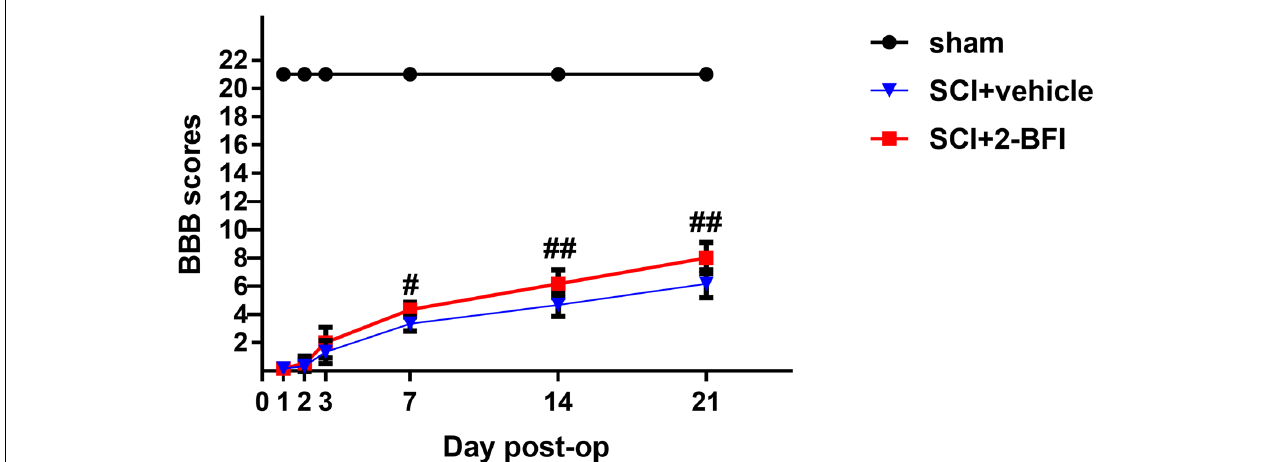
FIGURE 2 | The locomotor recovery test after SCI was evaluated by the BBB locomotor rating scale. Although the 2-BFI treatment improves functional recovery (BBB scores) at 3 days after SCI, no significant differences were demonstrated. However, compared with the SCI+vehicle group, the BBB scores were significantly increased in the SCI+2-BFI group at 7, 14 and 21 days after SCI. Values are the mean ± SD. # P < 0.05 vs. the SCI+vehicle group; ## P < 0.01 vs. the SCI+vehicle group.